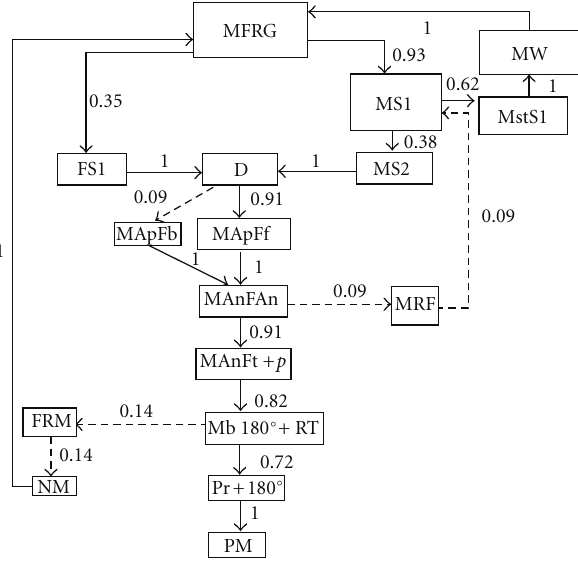
Figure 3: Sequence of courtship and mating behavior of Edessa meditabunda . Values represent the probability of transitions between behaviors. Solid-line arrows indicate the significant transi- tions ( P < 0 . 05) and dashed-line arrows not significant transitions ( P > 0 . 05). Boxes representing behavioral categories are in relative size to the frequency-observed behaviors from 62 pairs (male and female) observed. Codes for behavioral categories are listed